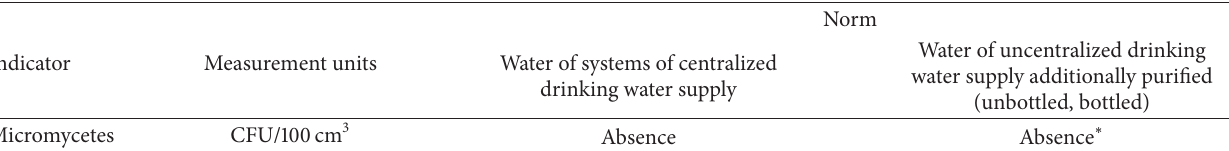
Table 2: Mycological indicators of drinking water